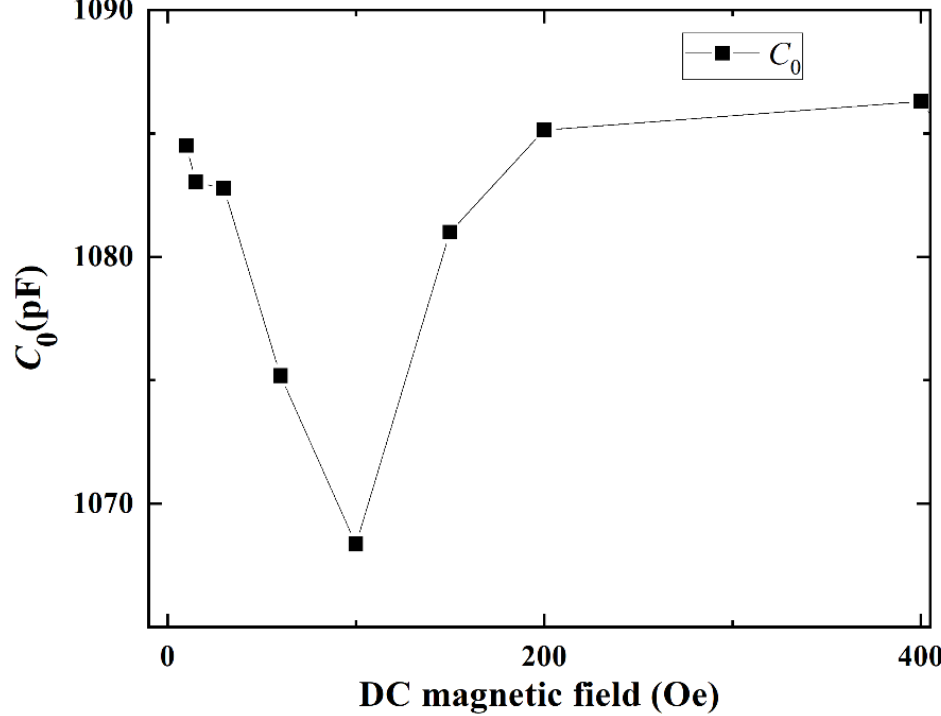
Figure 6. C 0 of the ME sensor as function of DC magnetic field. The maximum RSD of C 0 with multiple measurements is 0.25%.